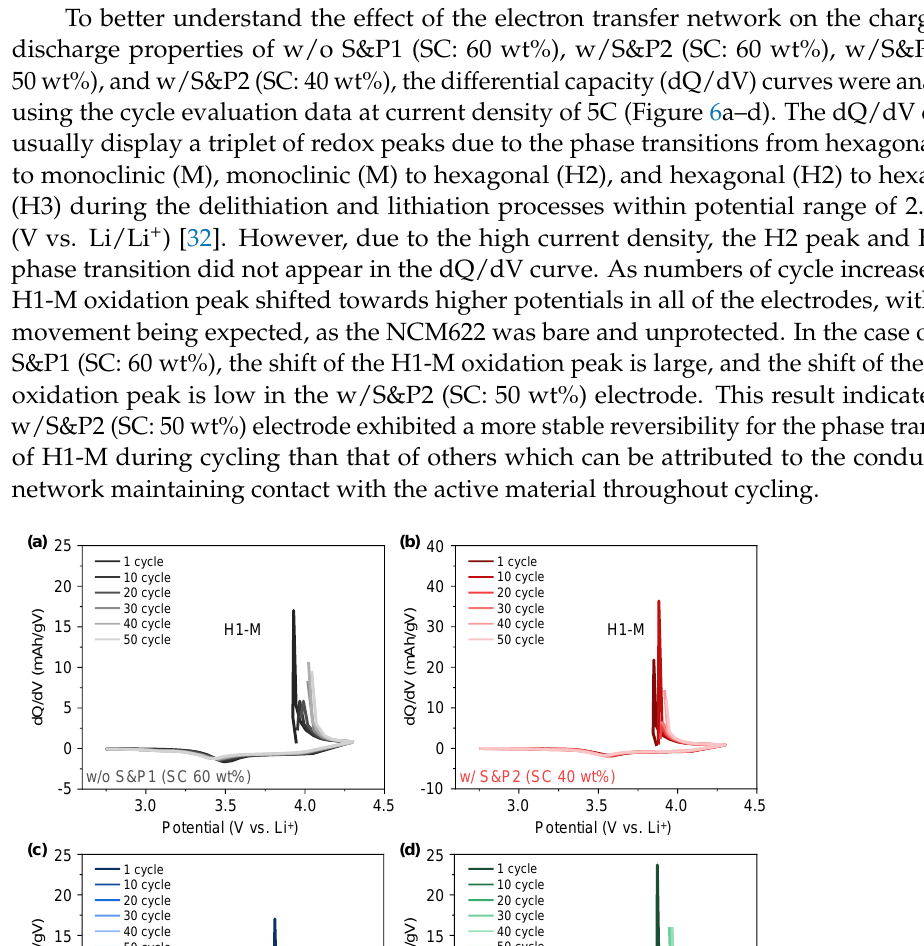
Figure 3. ( b ) the following 50-cycle performance at 5C at 30 °C. ( c ) Coulombic efficiency with charge and discharge C-rates of 5C. ( d ) Average voltage changes over the 50 cycle tests.